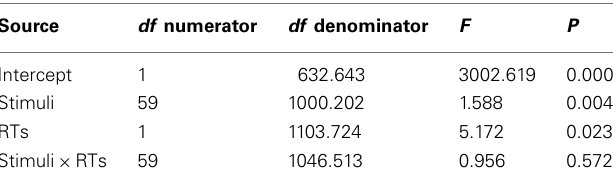
TableA1 |Type III tests of fixed effects in linear mixed model analysis testing the influences of stimuli and image generation time (RTs) on vividness ratings.